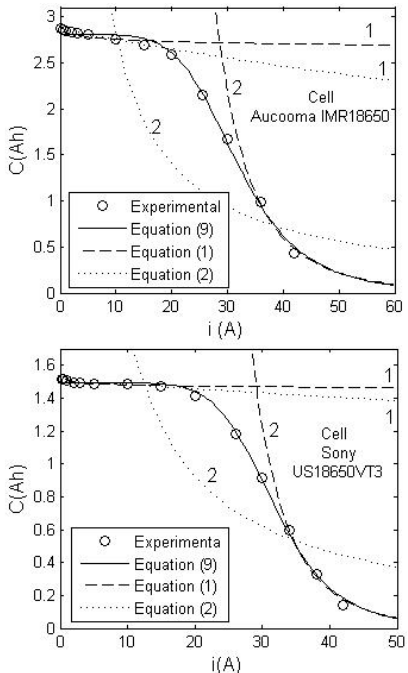
Figure 3. Comparison between experimental data for lithium-ion cells of different types and Equations (1), (2) and (9). Number 1 marks the Peukert and Liebenow equations at small discharge currents while Number 2 at high discharge currents.